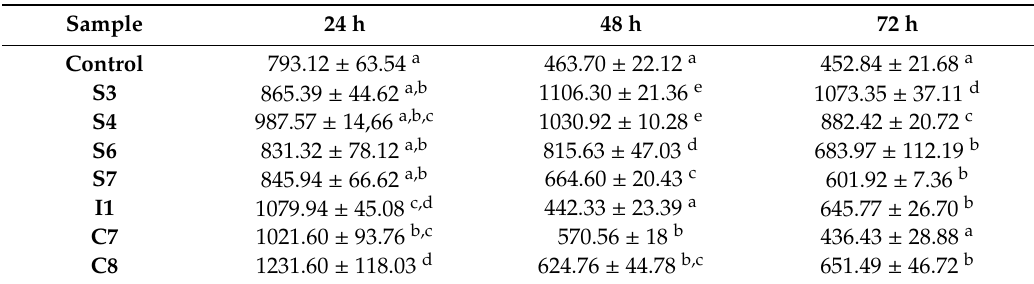
Table 4. Antioxidant activity ( µ M Trolox equivalent) of the meat broth with 2% glucose fermented by the selected bacteria at 37 ◦ C for 24, 48, and 72 h.